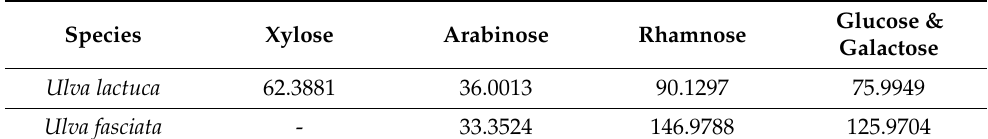
Table 3. Monosaccharide composition (mg/g) of the polysaccharides extracted from the green seaweeds Ulva lactuca and Ulva fasciata.